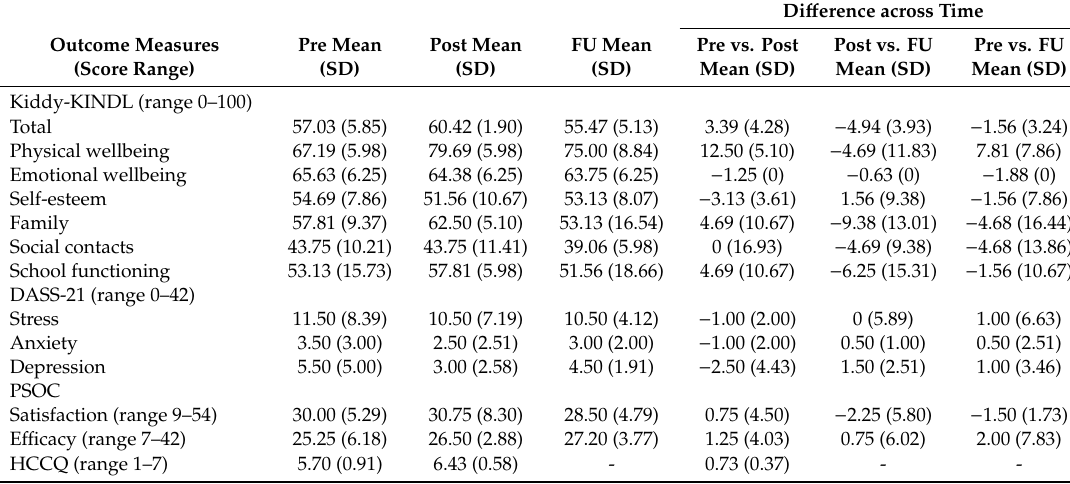
Abbreviations: DASS-21, Depression, Anxiety and Stress Scale-21; PSOC, Parenting Sense of Competence Scale; HCCQ, Health Care Climate